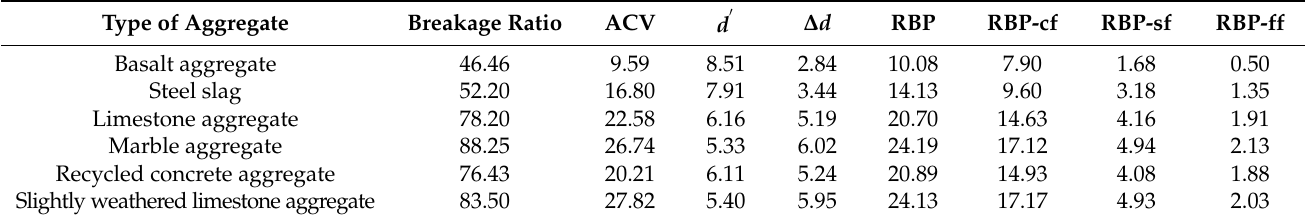
Table 3. Results of aggregate crushing characteristics under static ACVTs.